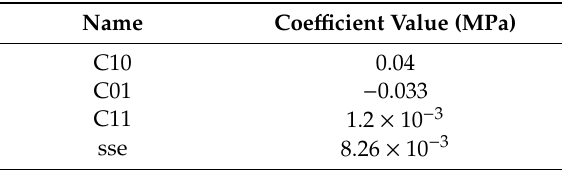
Table 1. The incompressible hyperelasticity of the silicone, which is determined to be a third-order Mooney–Rivlin